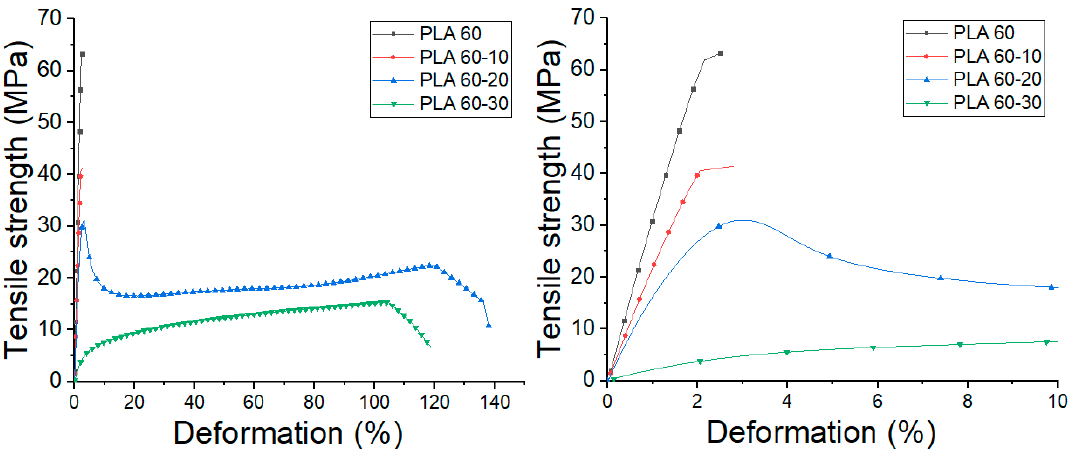
Polymers 2018 , 10 , x FOR PEER REVIEW Figure 8. Average tensile stress vs. deformation PLA and PLA-ATBC processed at 60 rpm.